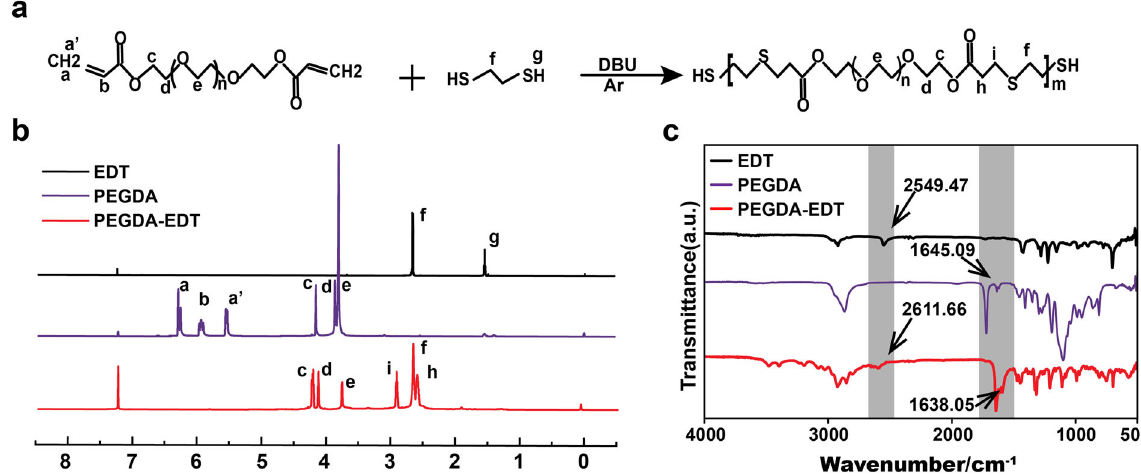
Fig. 2 The synthetic route and characterization of PEGDA-EDT. a Synthetic route of PEGDA-EDT. b 1 H-NMR and c FTIR spectra of the